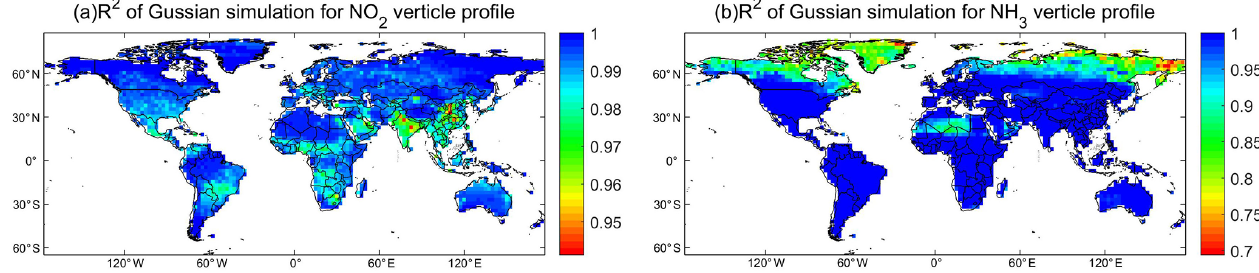
Figure 11. Spatial distributions of R 2 for a Gaussian function by simulating NH 3 and NO 2 vertical profiles. This is an example of Gaussian fitting using 47 layers’ NH 3 and NO 2 concentration from an ACTM (GEOS-Chem).